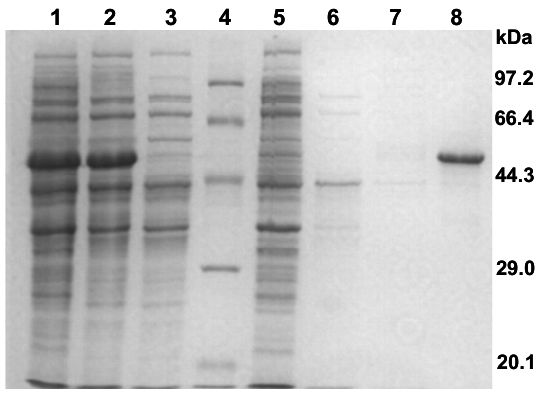
Figure 3. SDS-PAGE gel electrophoresis of the purified CbPelA protein. Lane 1: supernatant of the cell lysate treated by ultrasound; Lane 2: supernatant of the product after thermo-treatment; Lane 3: elution product following filtering through a Ni–NTA agarose column; Lane 4: protein marker; Lanes 5–8: samples eluted with 0, 20, 50, or 100 mM imidazole, respectively. Molecular mass is indicated at the right of the figure.